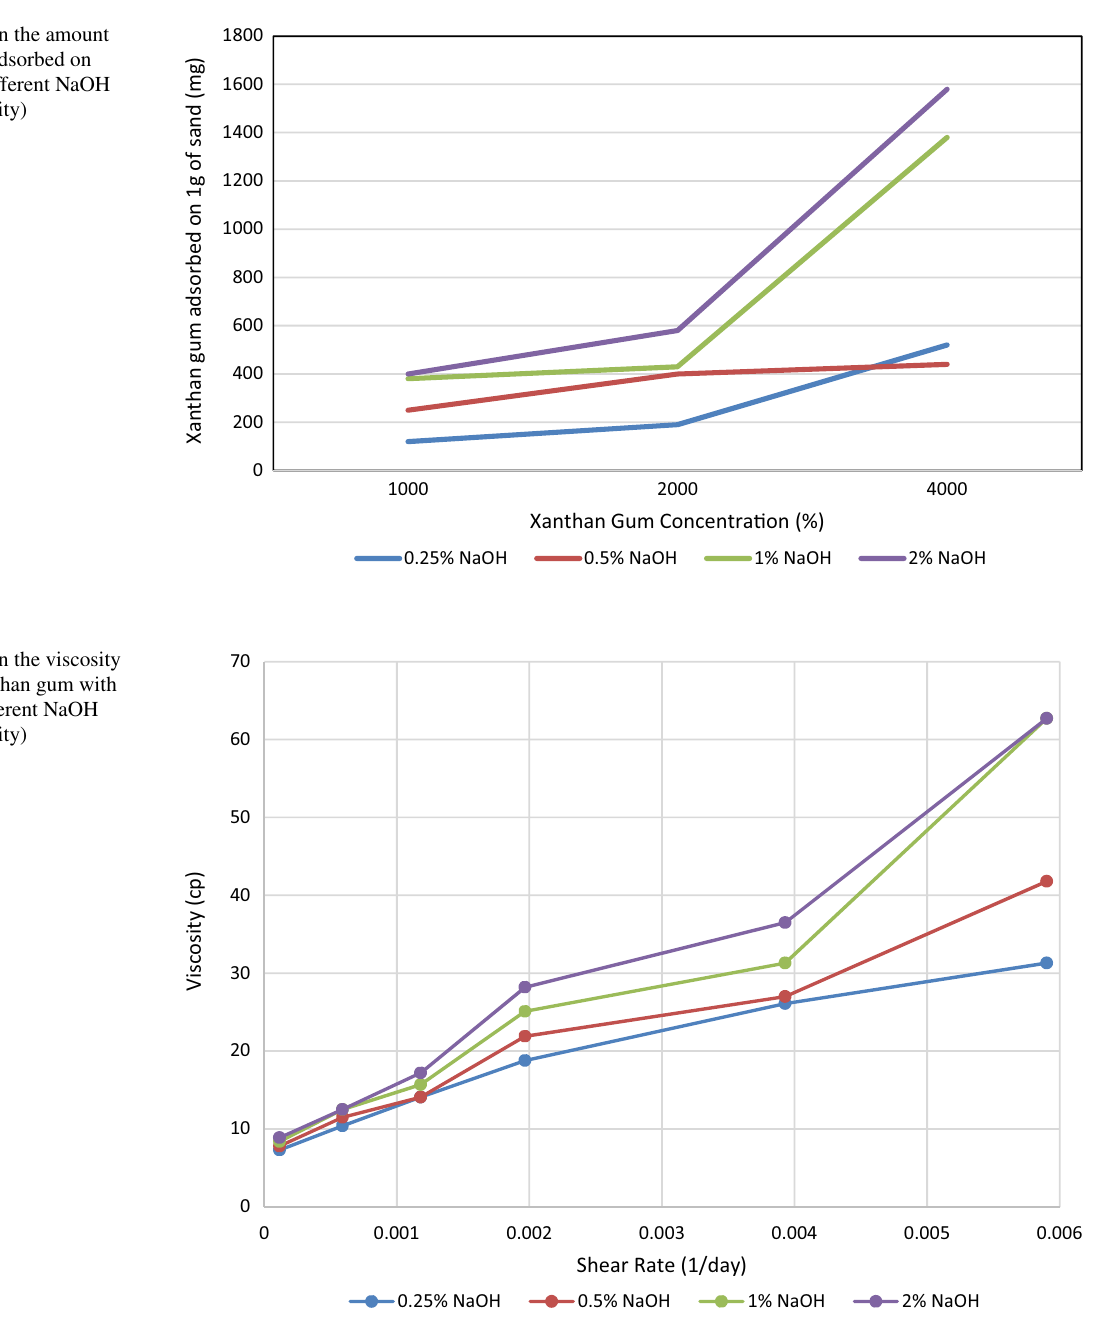
Fig. 8 Variation in the viscosity of 1000 ppm xanthan gum with shear rate for different NaOH additions